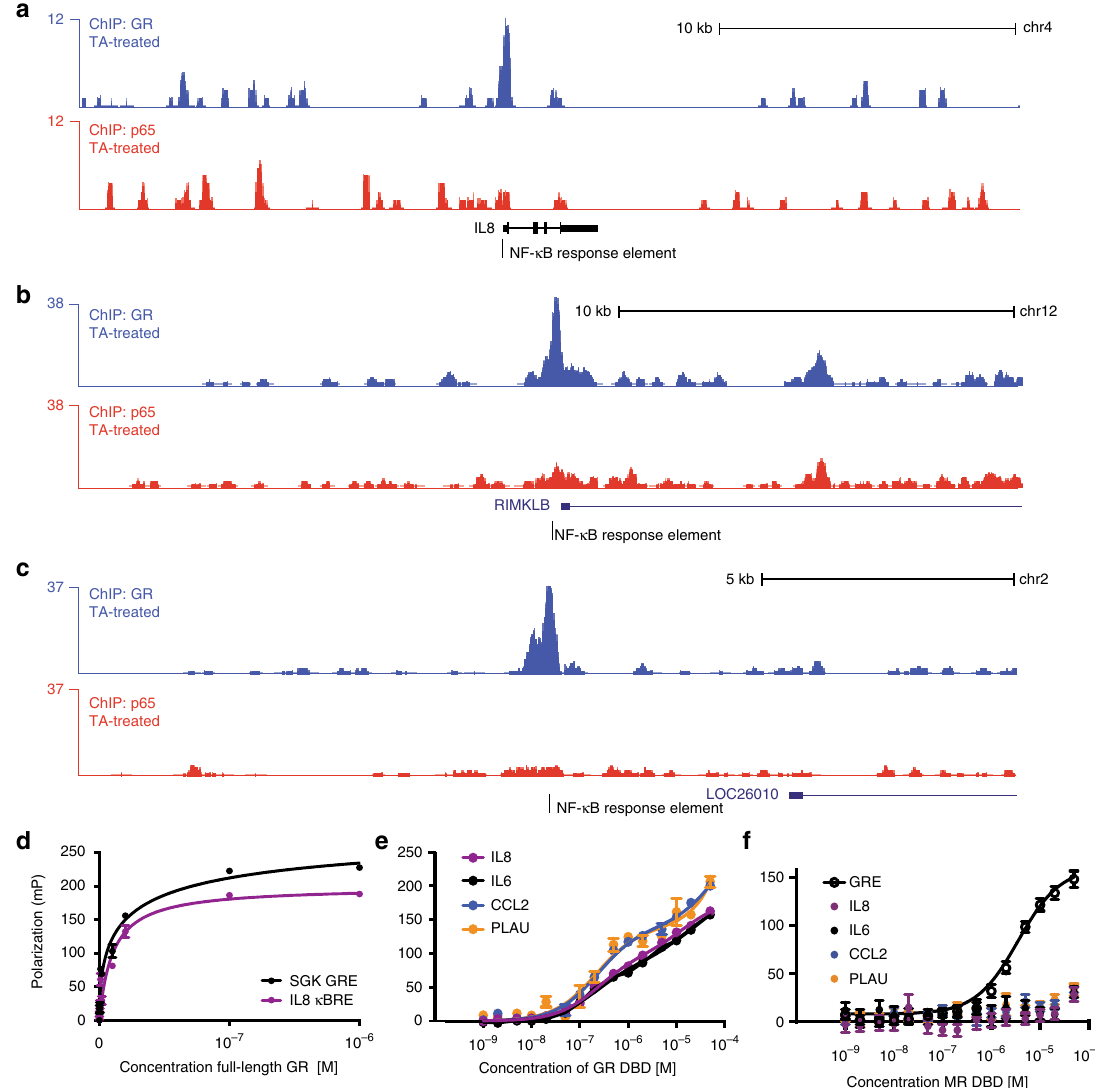
Fig. 2 GR is recruited directly to NF- κ B response elements. a – c ChIP-seq data from HeLa cells activated with the GR agonist triamcinolone acetonide shows activated GR is recruited to NF- κ B response elements, even without the presence of p65 as a tethering factor. d In vitro fl uorescence polarization binding experiments with full-length GR shows that its af fi nity for the IL8 NF- κ B response element and SGK1 ( + )GRE are similar (51 and 35 nM, respectively). e GR DBD binding to four human κ BREs showed two-site binding curves, similar to that of GR DBD when binding to an nGRE 19 (mean + SEM, n = 3; Supplementary Table 5). An extra sum-of-squares F -test was used to compare a two-site speci fi c binding event to a one-site speci fi c binding event; the resulting p -values are shown in the left column of the panel. f The mineralocorticoid receptor DBD binds to a ( + )GRE, but not to any of the κ BREs tested (mean + SEM, n =